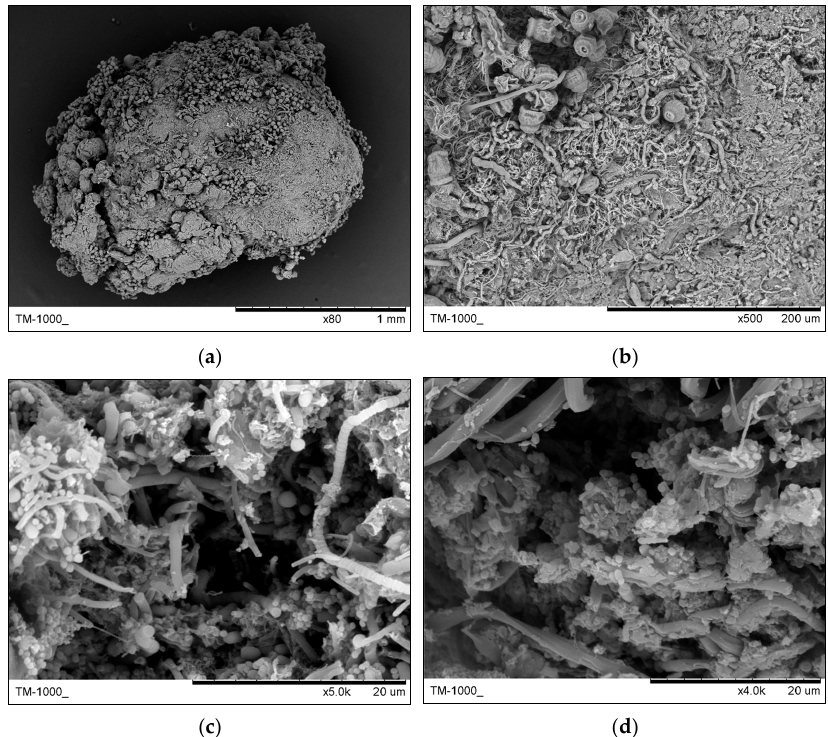
Figure 7. Structure of the granule with stalked ciliates ( Epistylis sp.) by SEM. ( a ) A granule from SBR2; ( b ) surface layer of the granule; ( c ) middle layer of the granule; ( d ) core layer of the granule.